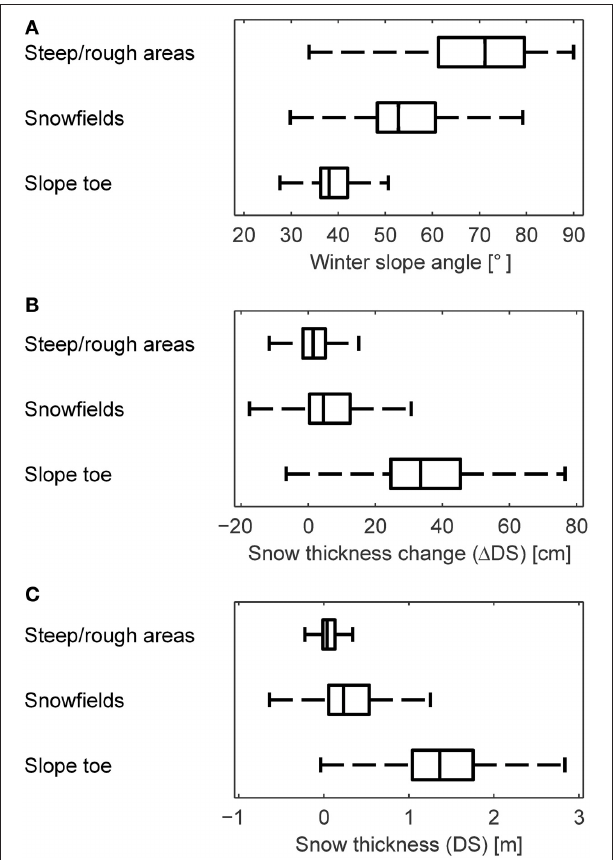
FIGURE 4 | Comparison of the subareas with regard to (A) winter slope angle, (B) snow thickness change during the snowfall, and (C) snow thickness on 25 March. The flatter the subarea, the more snow was accumulated and the higher was the total snow thickness. The medians’ 95% confidence intervals are so small that the notches are not visible. The outliers are not